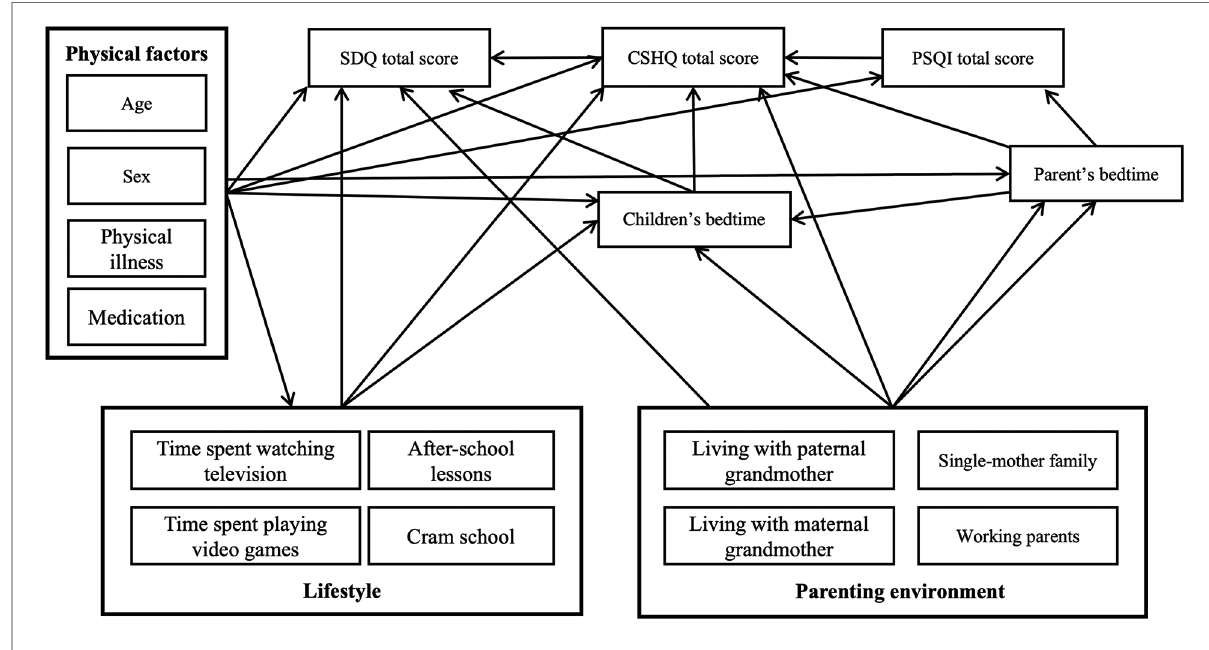
FIGURE 1 Path diagram hypothesizing the complex interrelationships among factors. We divided non-sleep-related factors that may affect the SDQ total score into physical, lifestyle, and parenting environment factors. SDQ, Strengths and Dif fi culties Questionnaire; CSHQ, Children ’ s Sleep Habits Questionnaire; PSQI, Pittsburgh Sleep Quality